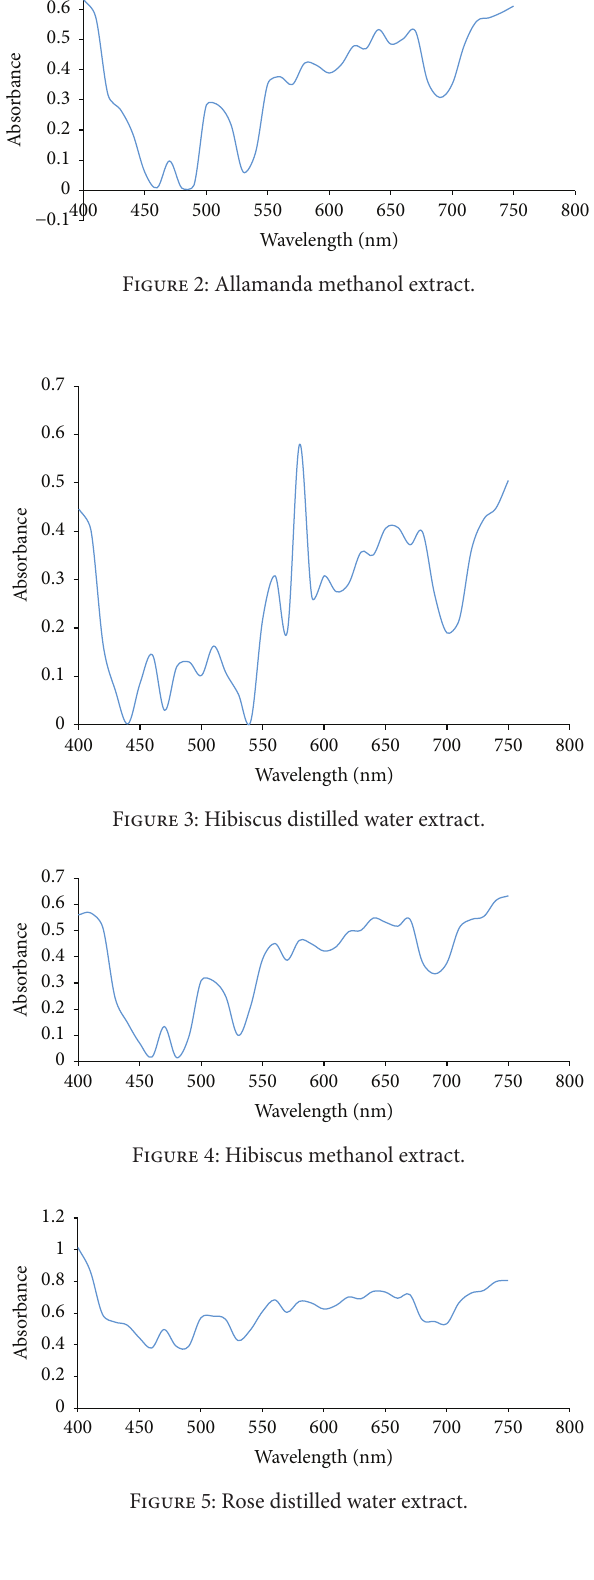
have more than one peak indicating the different components present in each of the samples and at visible